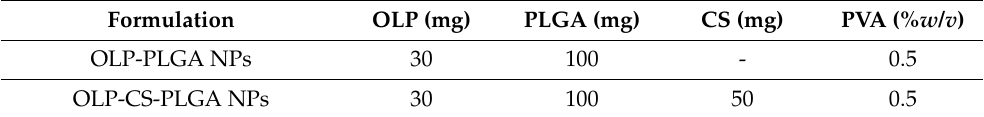
Table 1. Composition of